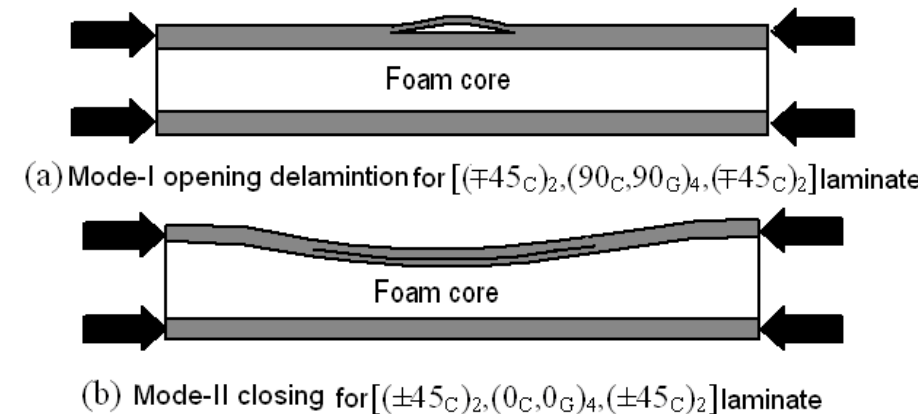
Figure 19. ( a , b ) Different buckling modes of the two sandwich specimens with different face laminates.